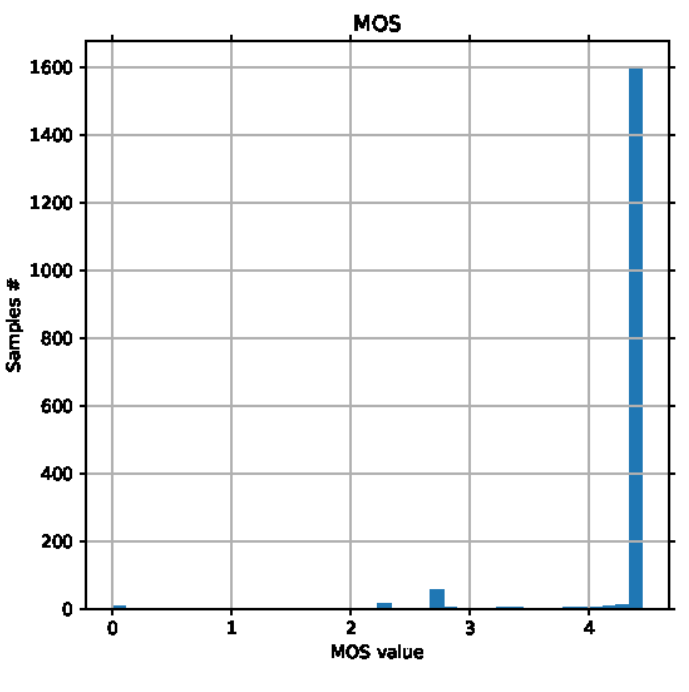
Figure 7. MOS Distribution.